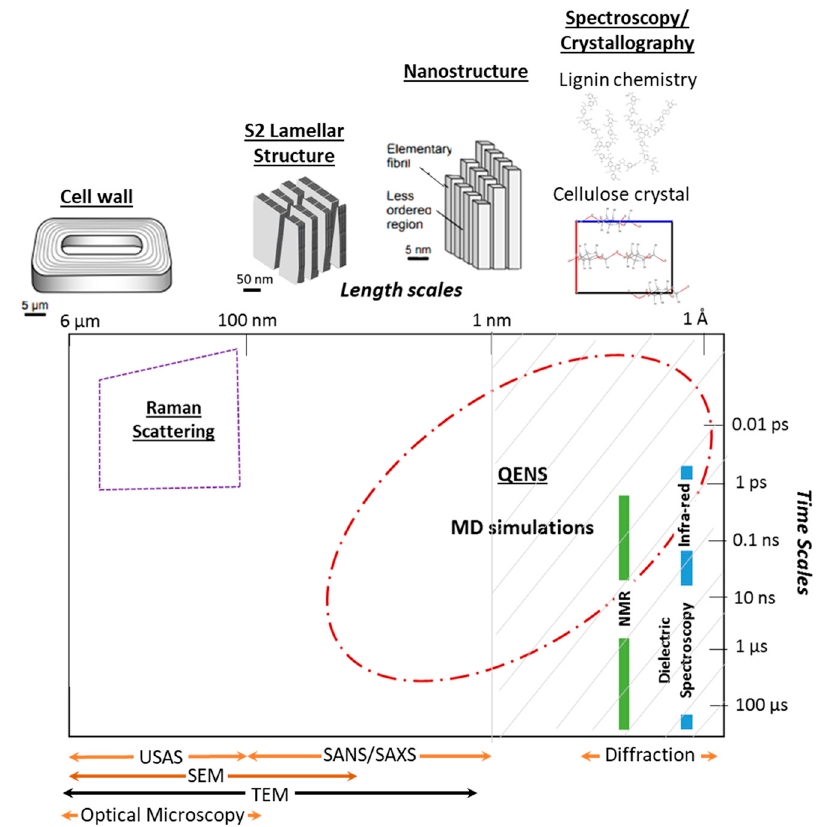
Figure 1. Conventional techniques used to study wood across several length and time scales. The relevant wood structure is included for comparison purposes. This perspective focuses on the molecular-scale interactions. The techniques applicable can probe length scales from 1 nm to 1 Å and time scales from 0.01 ps to 100 µs. Techniques listed in the figure (from left to right) include: ultra-small angle scattering (USAS), small angle neutron scattering (SANS) and small angle x-ray scattering (SAXS), scanning electron microscopy (SEM), transmission electron microscopy (TEM), quasielastic neutron scattering (QENS), molecular dynamics (MD) simulations, and nuclear magnetic resonance (NMR). Figure adapted from Martinez-Sanz et al. [27].